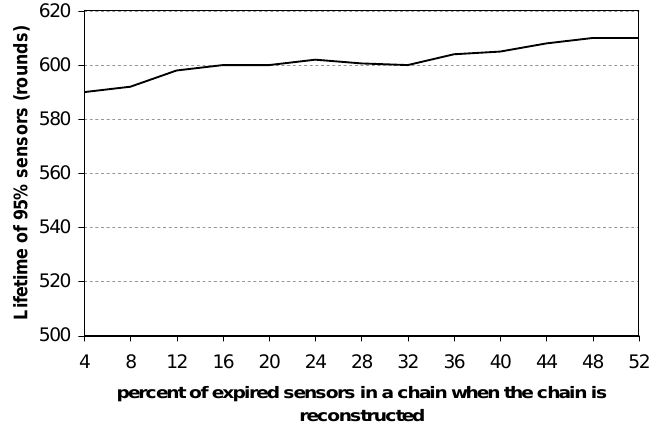
Figure 11. Network lifetime vs . percent of expired sensor nodes in a chain when the chain is reconstructed.